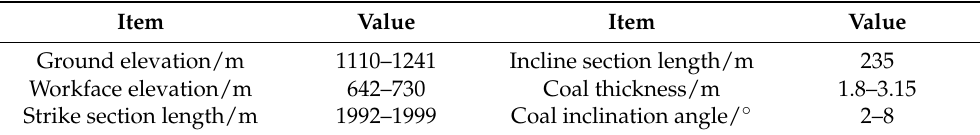
Table 1. The basic situation of the workface.